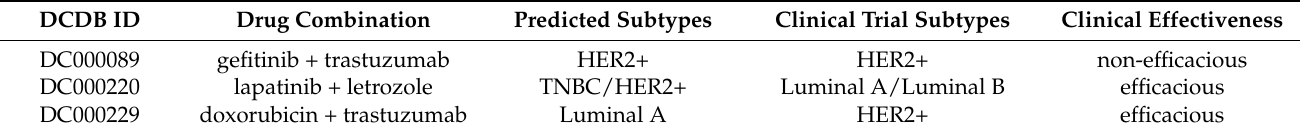
Table 5. Actual and predictive activity of BC drugs (inconsistent).